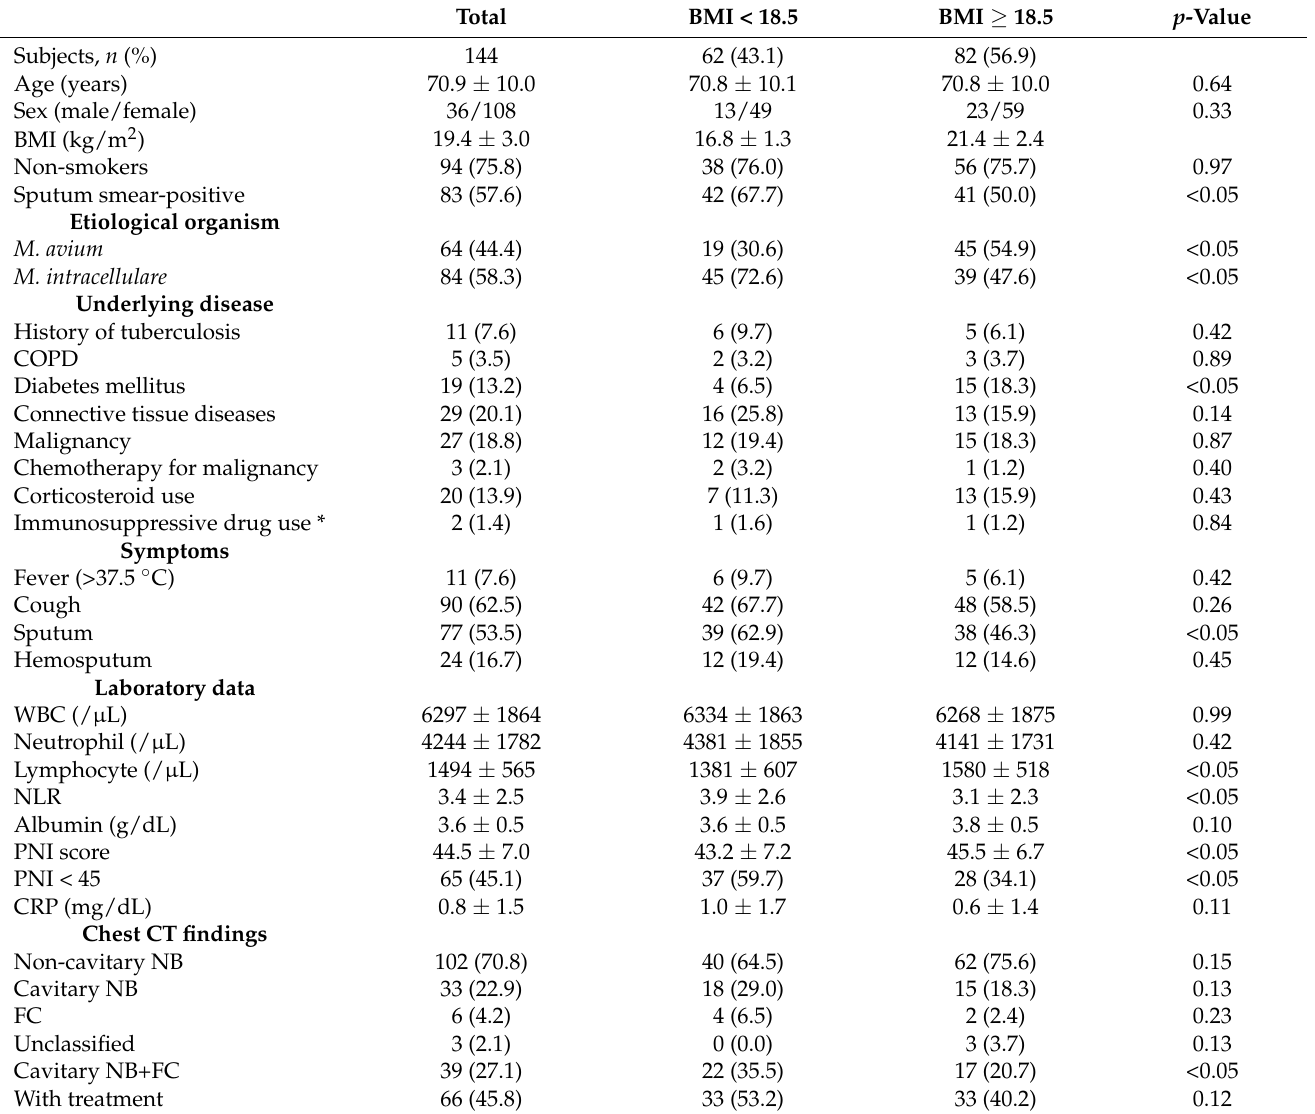
Table 1. Clinical characteristics of the MAC-PD patients with a BMI < 18.5 kg/m 2 or ≥ 18.5 kg/m 2 . Total BMI < 18.5 BMI ≥ 18.5 p